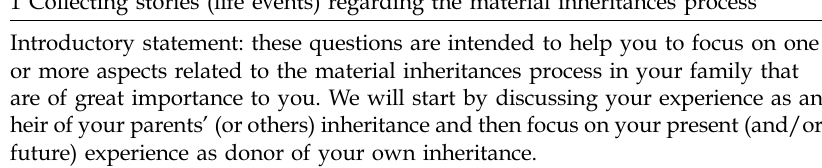
Table 1. SCM inter v iew